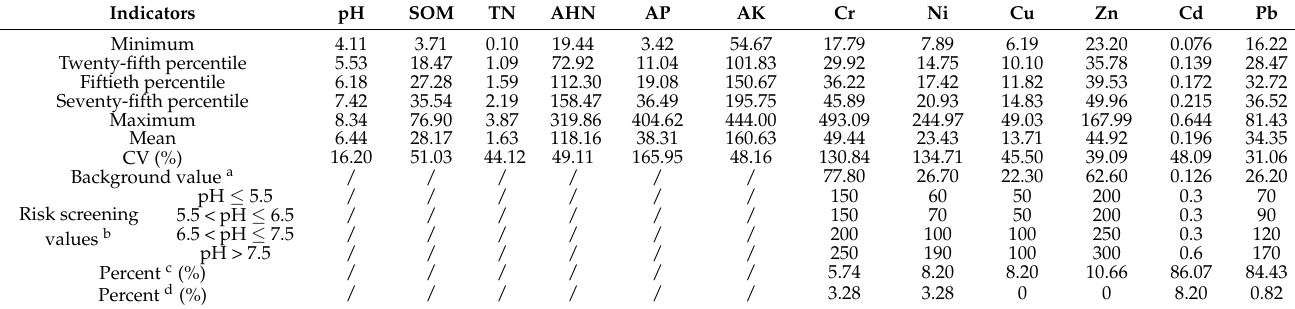
Table 3. Descriptive statistics of soil quality indicators in the study